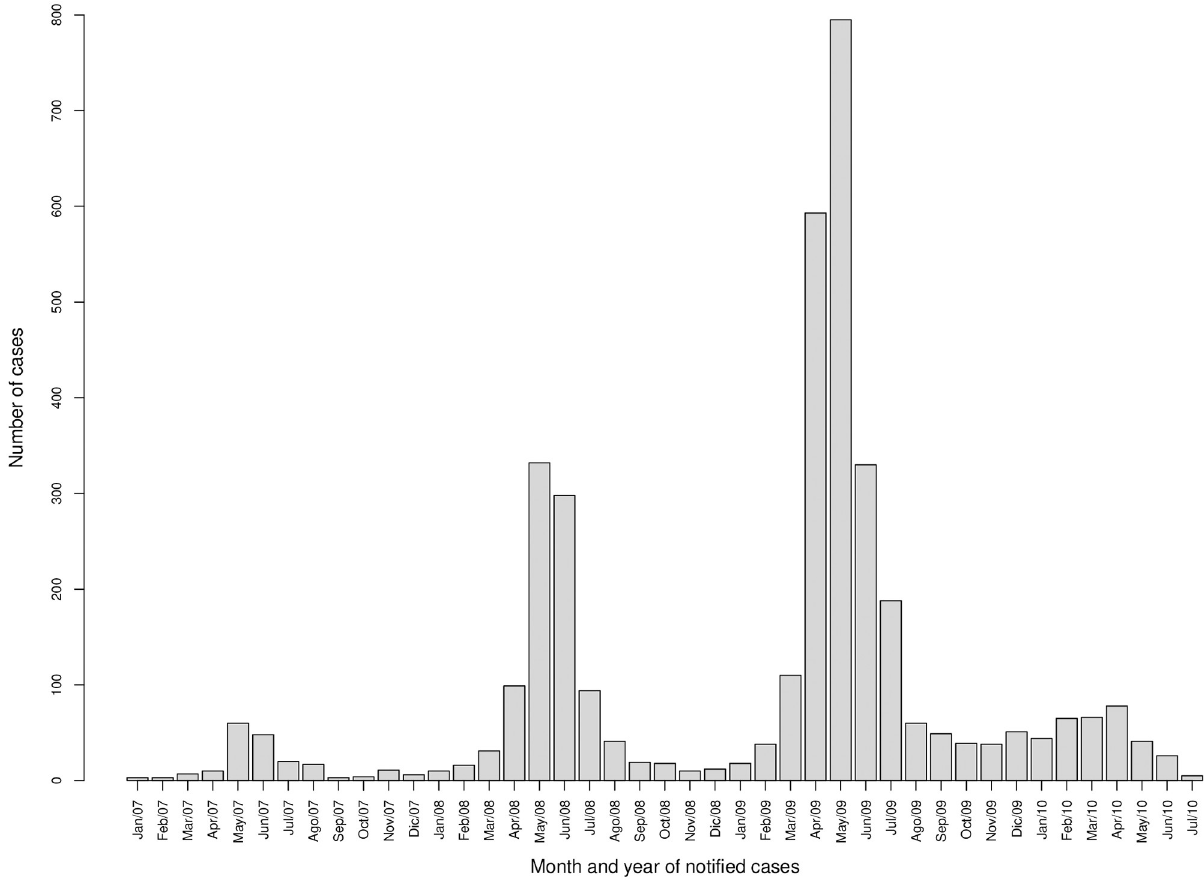
Fig 1. Human Q fever cases in the Netherlands grouped per months, from January 2007 to July 2010.